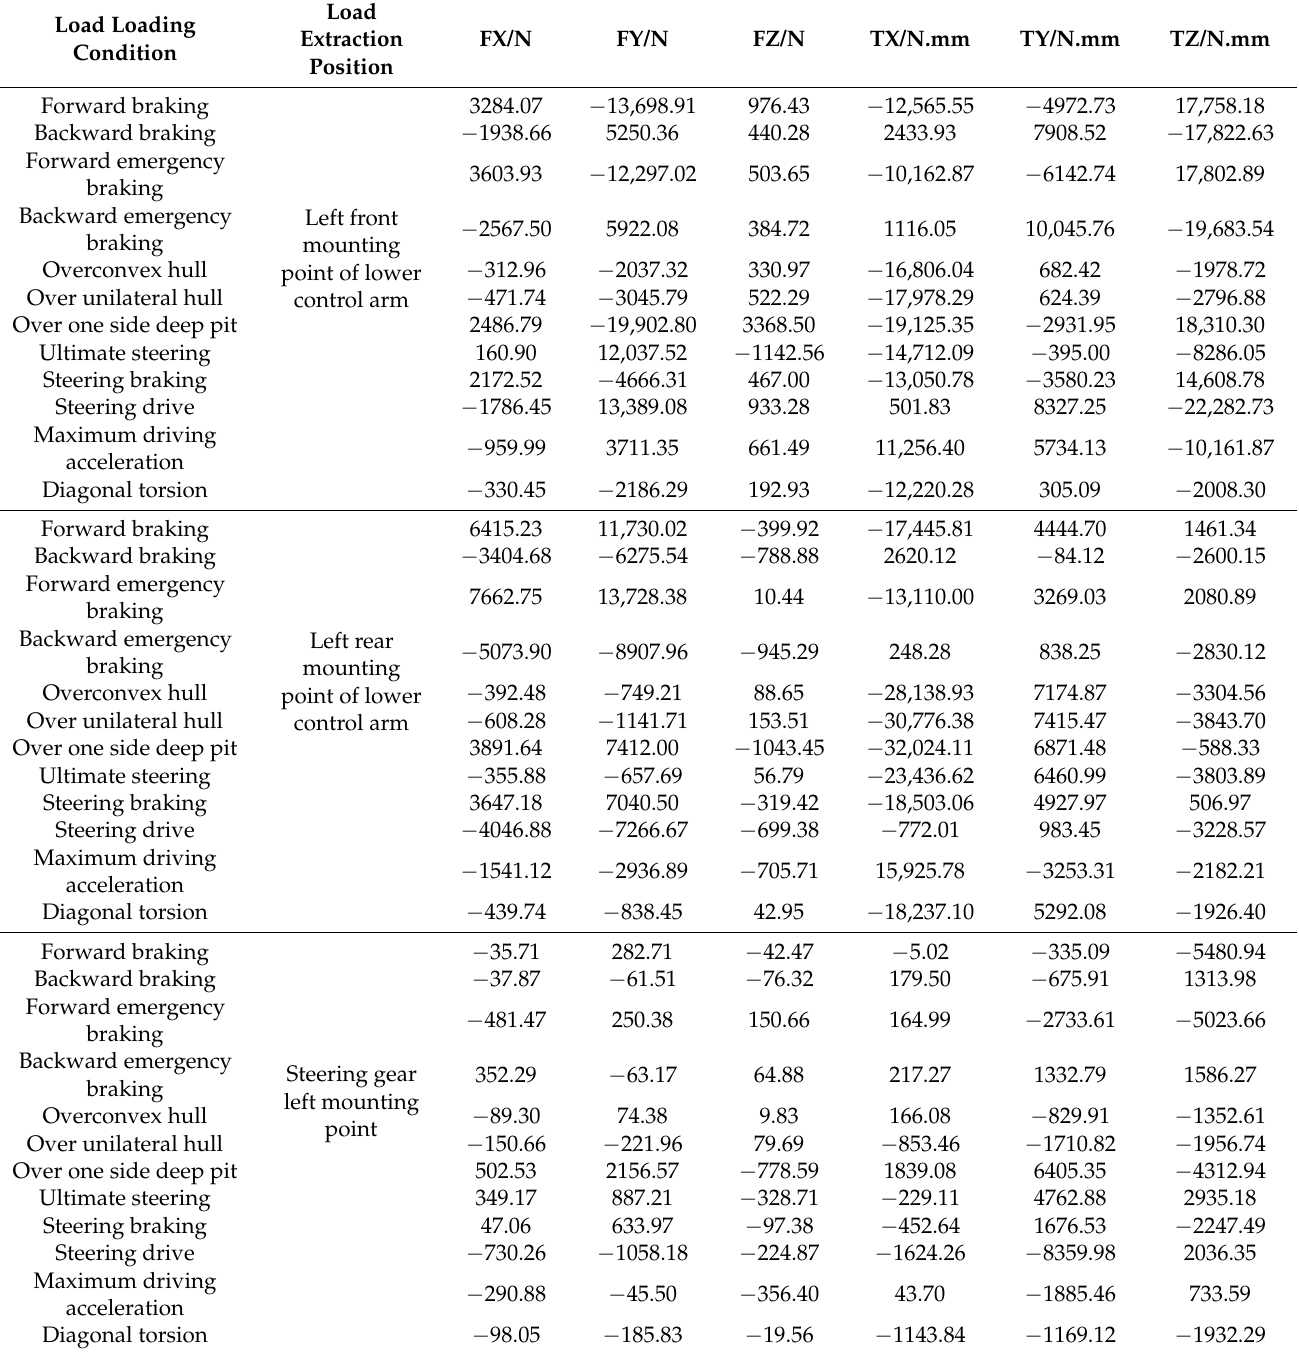
Table 1. Summary of load information of each typical working